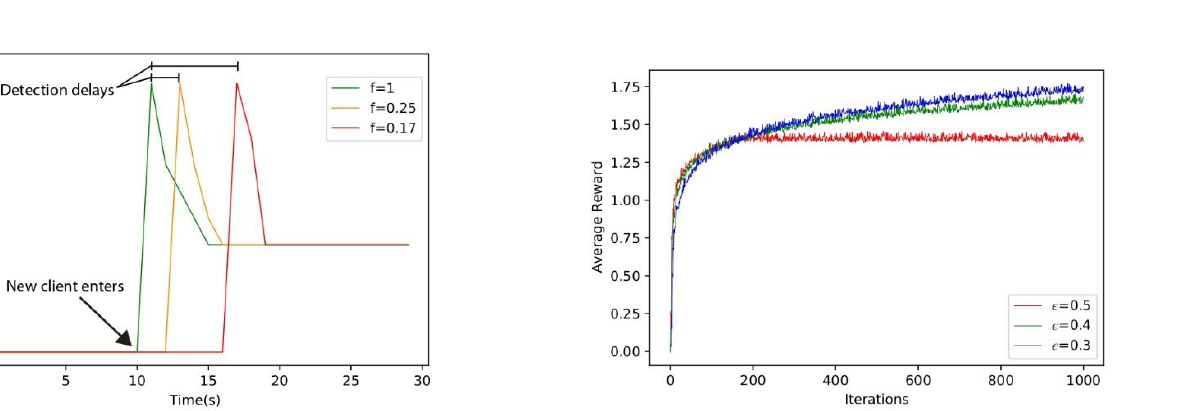
Figure 6. Detection delay comparison with different twinning frequencies